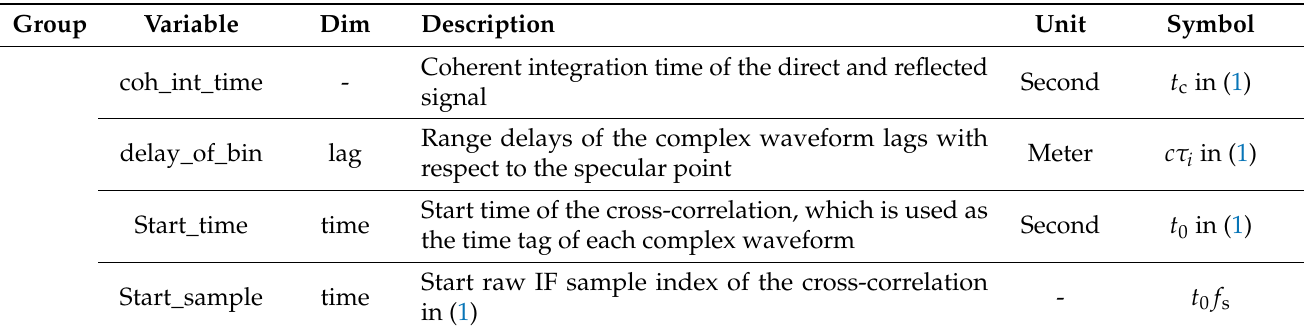
Figure 4. Structure of the complex waveform product derived from GNSS-R raw IF data collected by different spaceborne missions. The product is in netCDF (network Common Data Form) format. Each netCDF file contains the complex waveforms and relevant metadata in different groups. Table 2. Definition and explanation of the variables in the complex waveform netCDF file of the spaceborne GNSS-R raw IF data